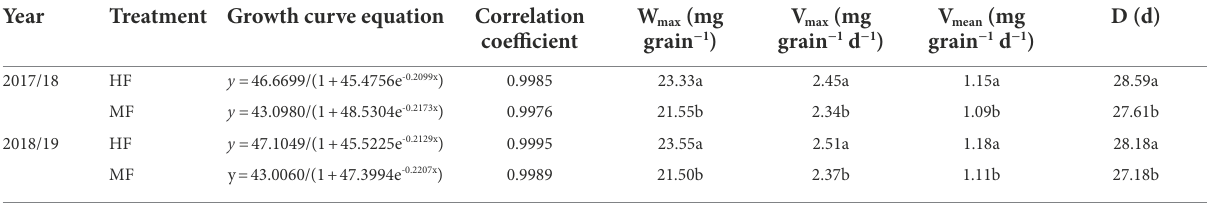
TABLE 3 The grain filling process model and grain filling parameters in 2017/18 and 2018/19 growing seasons. Year Treatment Growth curve